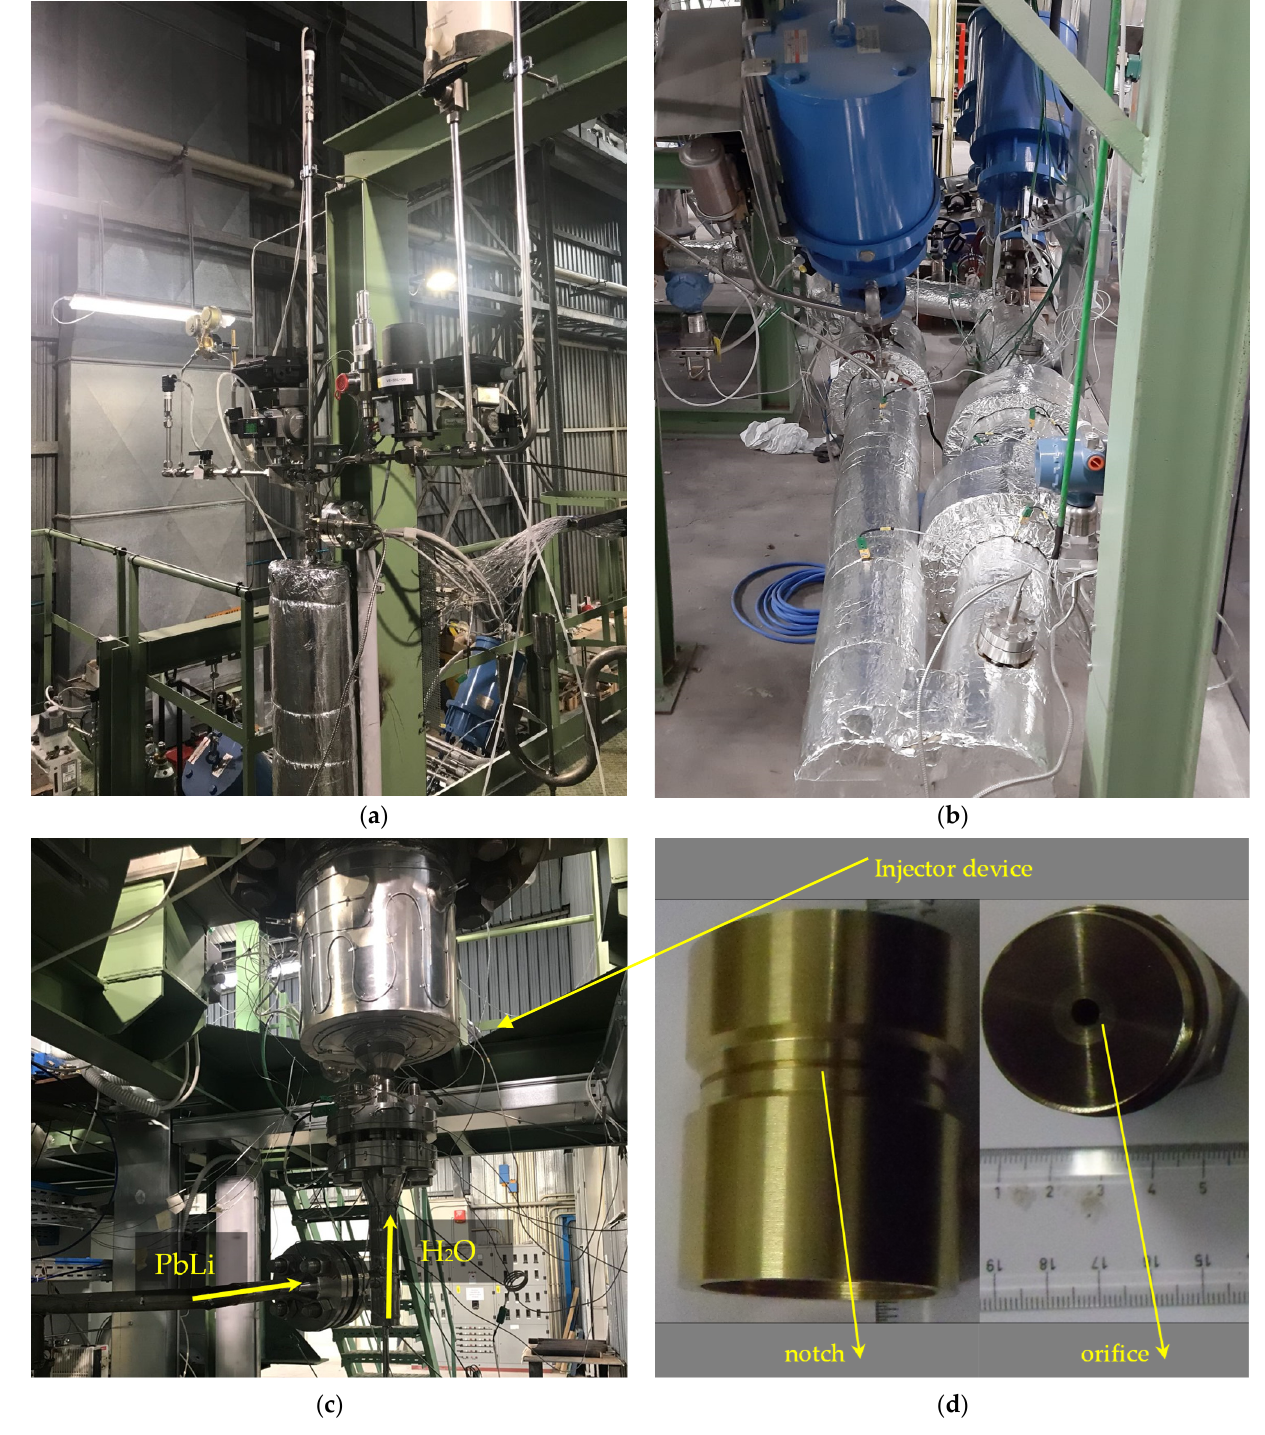
Figure 5. Detail of the injection line and device. ( a ) Upper part of the water injection line connected to argon gas cylinder; ( b ) injection line with valves and Coriolis; ( c ) injection piping and connection to the S1B vessel; ( d ) injector cover brass cap with specified notch dimensions.